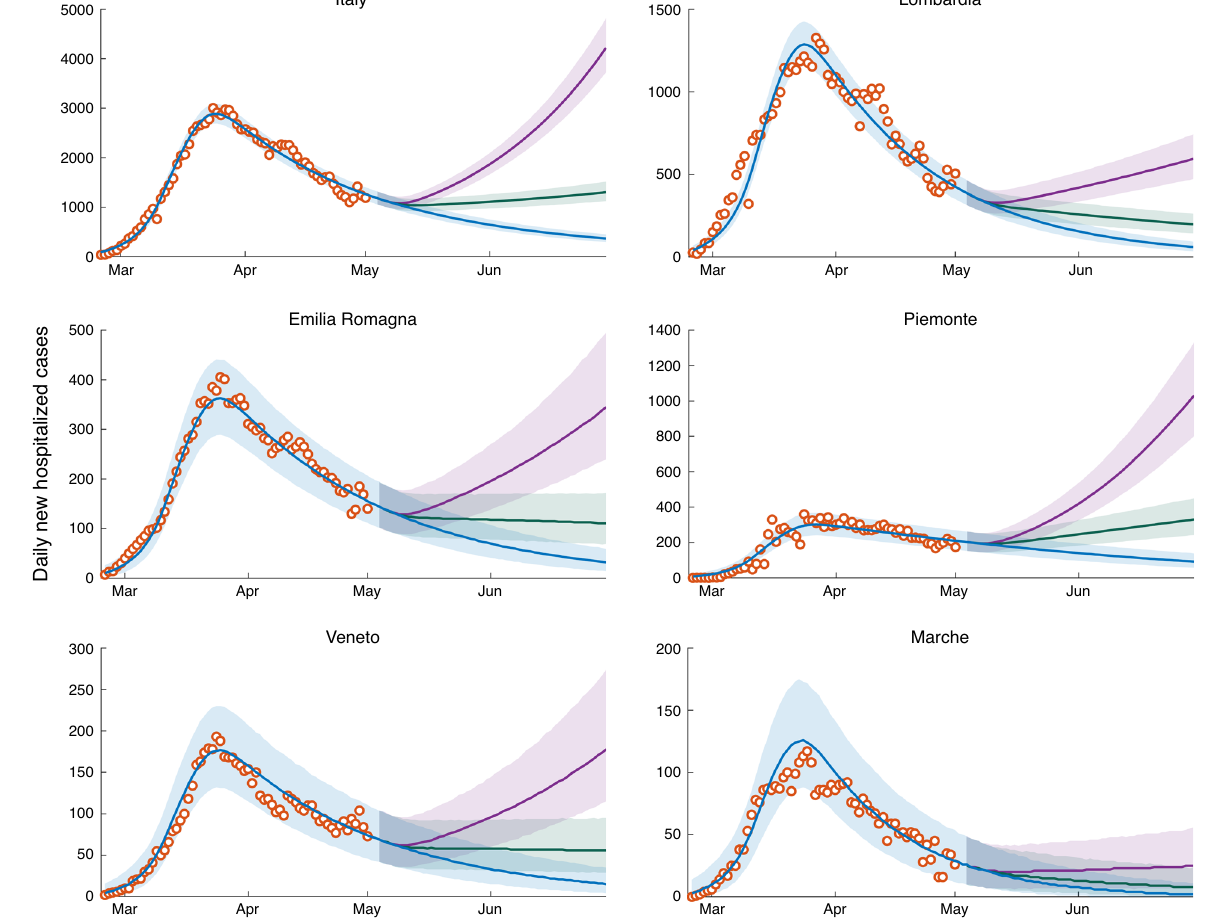
Fig. 2 Daily numbers of newly hospitalized cases for Italy and its hardest hit regions. Shown here are reconstructed data (empty circles), and model results (solid lines and con fi dence intervals). Clockwise from top: Italy, Lombardia, Piemonte, Marche, Veneto, and Emilia Romagna. The remaining regions are shown in Supplementary Fig. 1. The blue solid line represents the baseline scenario, i.e., the median of the computed results with transmission estimated during lockdown maintained inde fi nitely beyond May 3, 2020. The green and purple solid lines represent the scenarios corresponding to a release of the containment measures determining an effective increase in the overall transmission rates of, respectively, 20% and 40%. The 95% con fi dence intervals are color-coded in analogy to their median scenarios. Plots refer to a fraction of infections leading to heavy symptoms σ equal to 25%. Plots referring to the other two values considered ( σ = 50% and 10%) are reported in Supplementary Figs. 2 and